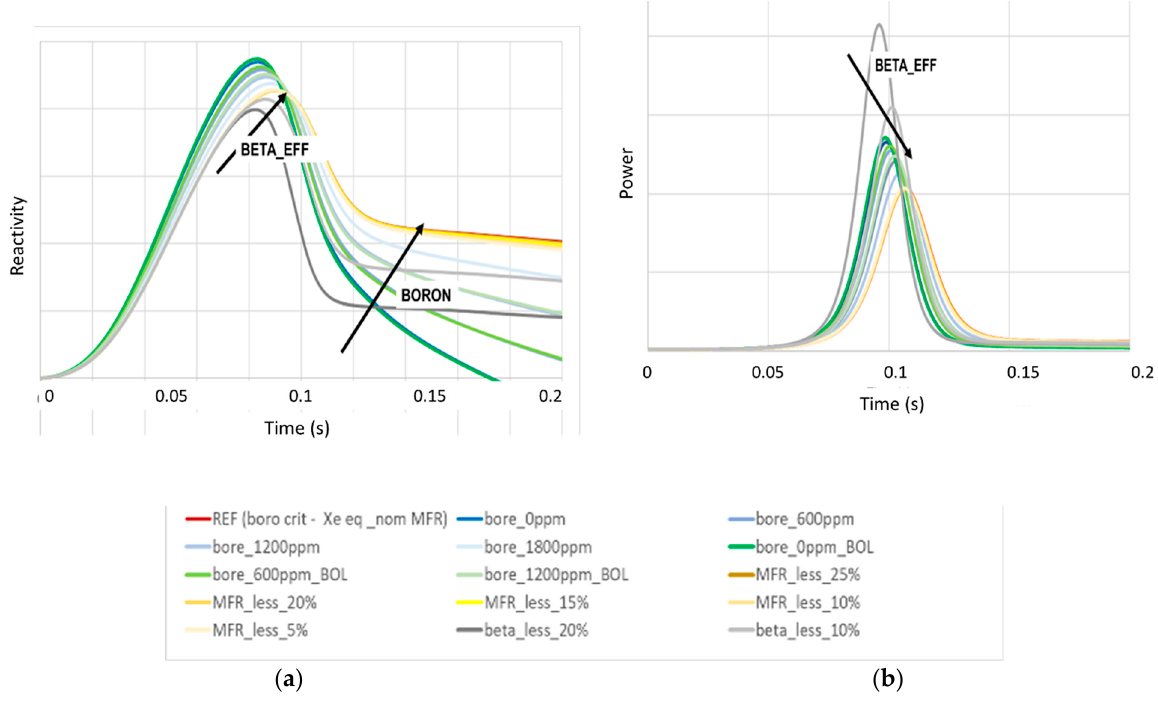
Figure 29. The 32 FA Minicore Case: a qualitative parametric study carried out over a restricted number of calculations: ( a ) reactivity; ( b ) power. Table 9. Core cases: parameters and distributions used for the SA.